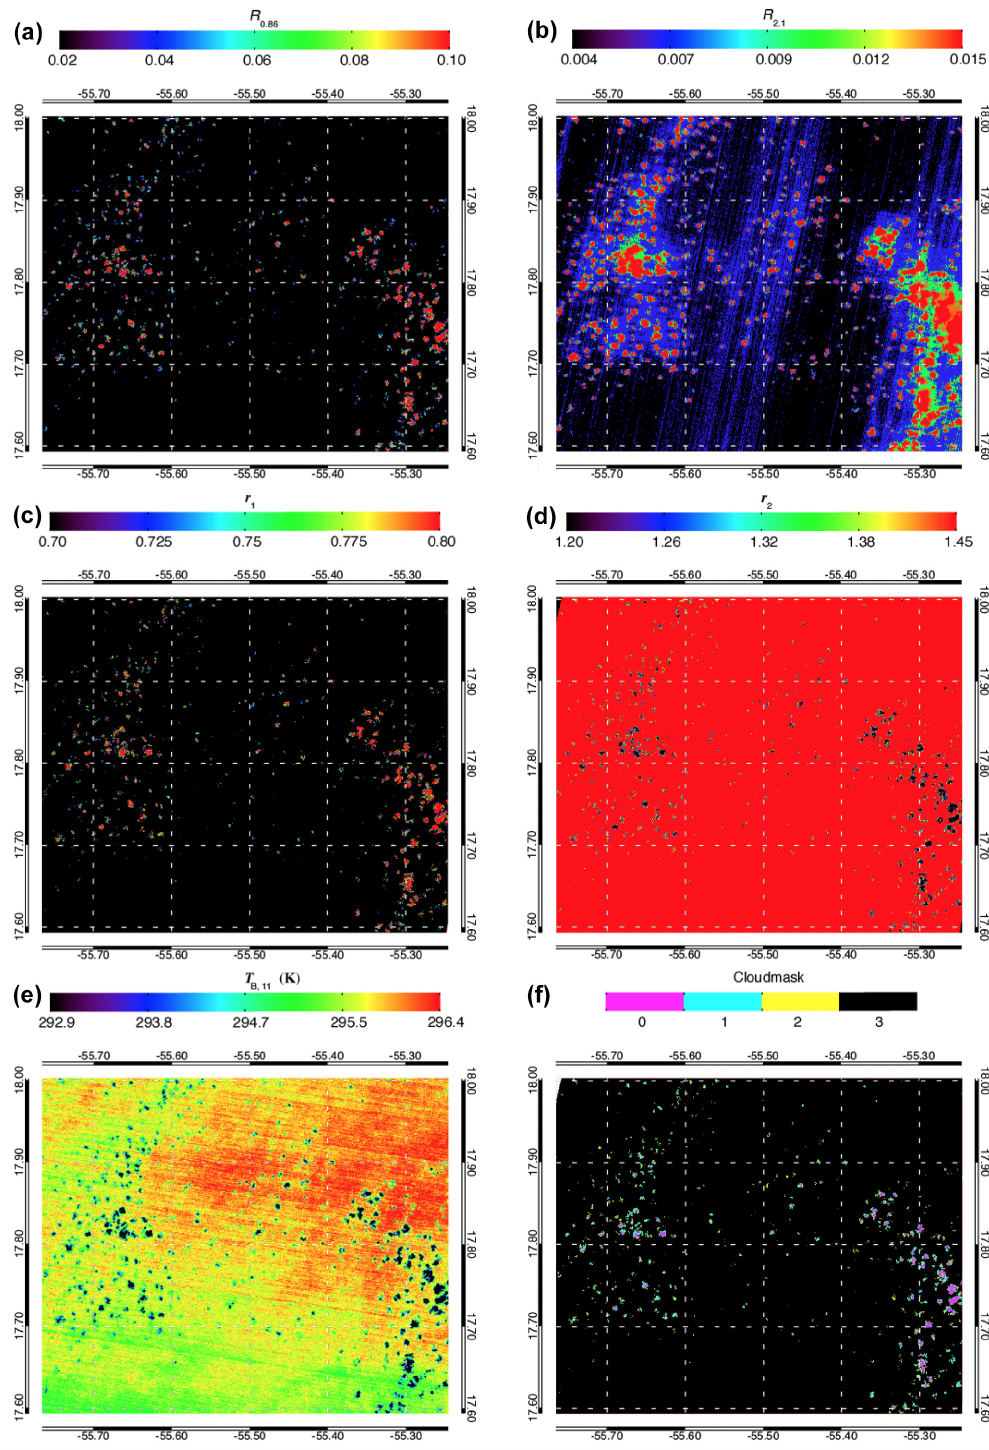
Figure 2. (a) Band 3N reflectance ( R 0 . 86 ) from ASTER observations on 2 December 2004 (i.e., cloud mask test i). (b) Same as (a) but show- ing the band 5 reflectance ( R 2 . 1 ) (i.e., cloud mask test ii). (c) Same as (a) but showing the color ratio r 1 (i.e., cloud mask test iii). (d) Same as (a) but showing the color ratio r 2 (i.e., cloud mask test iv). (e) Same as (a) but showing the brightness temperature T B , 11 (i.e., cloud mask test v). (f) Same as (a) but showing the cloudiness flags “0”–“3”, after applying cloud mask tests